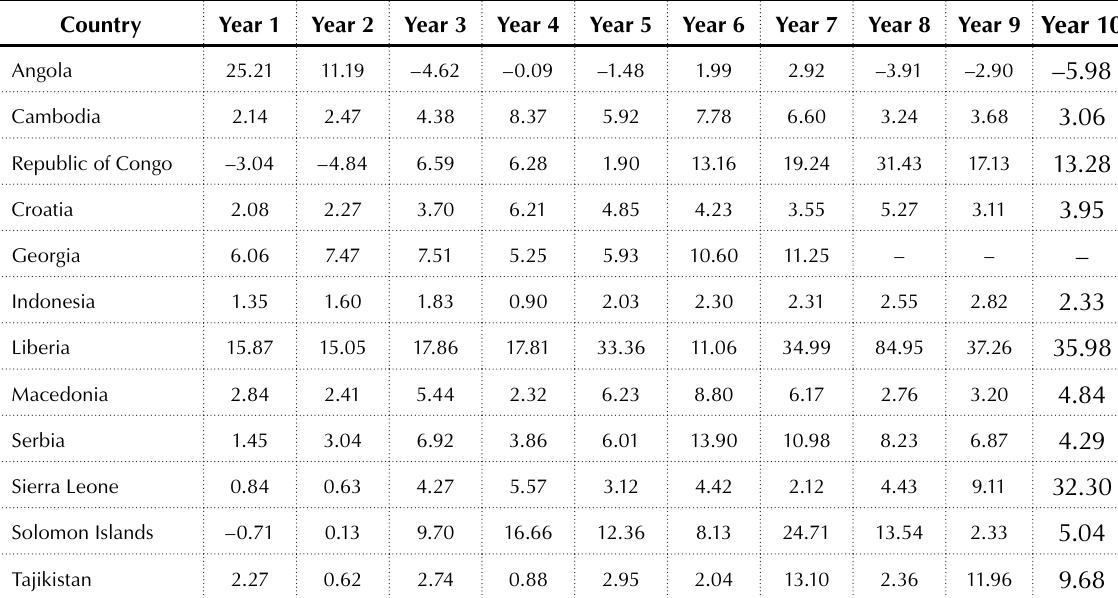
Table 7. Foreign direct investment (net inflows), % of GDP